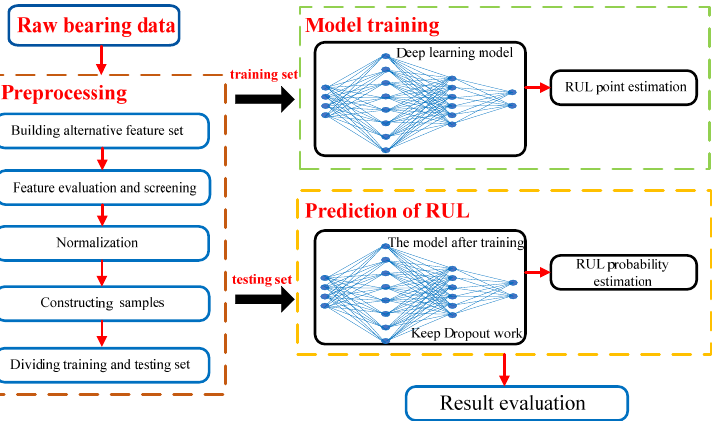
Figure 2. Flow chart of the bearing RUL prediction method based on LSTM and uncertainty quantification.